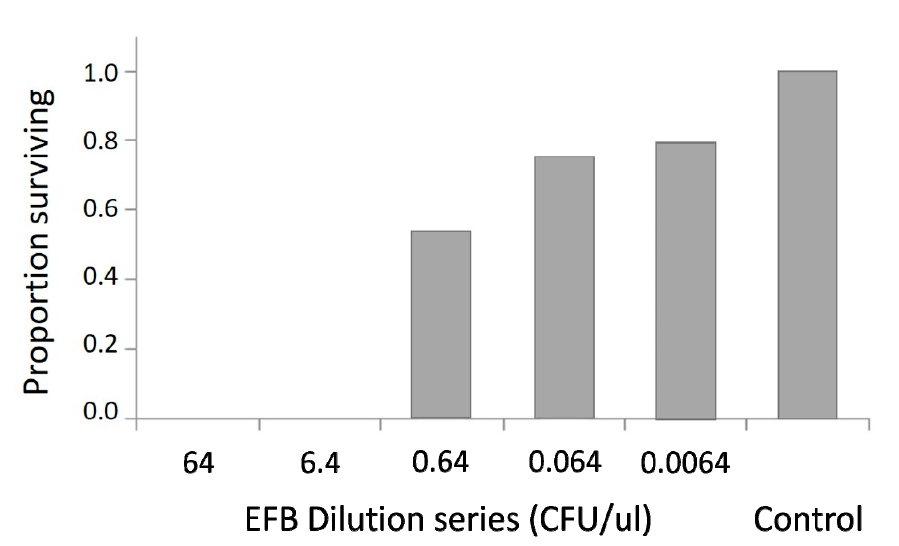
Figure 2. Survival of larvae exposed to a dilution series of M. plutonius strain AF5. Larvae were inoculated in vitro (N = 24 for each concentration) and survival was recorded at Day 6. The control received diet and saline with no bacteria. We designated the 6.4 CFU/µL dilution as LD100, and the 0.64 CFU/µL dilution as LD50 for use as positive controls in the in vitro rescue assay. Insects 2020 , 11 , x FOR PEER REVIEW